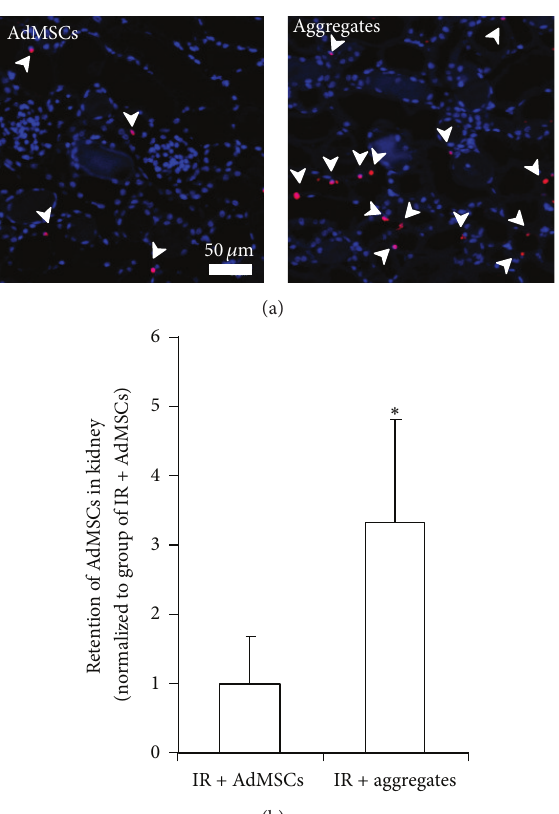
Figure 6: Retention of AdMSCs in kidney. (a) Representative images of EdU-labeled AdMSCs (indicated by white arrow) identified in kidney of rats underwent injection of 2D AdMSCs or 3D aggregates. (b) Results of EdU positive AdMSCs quantification in each high power field (HPF). Data were normalized to IR + AdMSCs group. ∗ 𝑃 < 0.05 compared to IR + AdMSCs